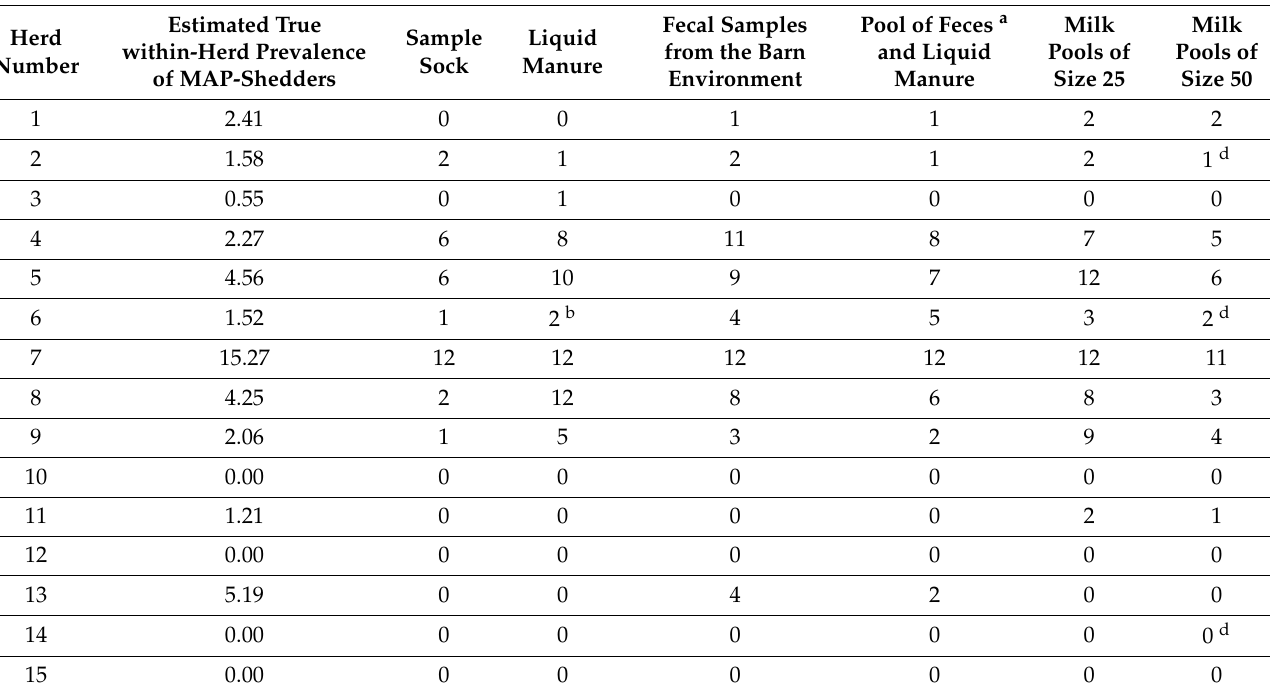
Table A1. Number of sampling events per herd with a Mycobacterium avium subsp. paratuberculosis (MAP)-positive result at herd